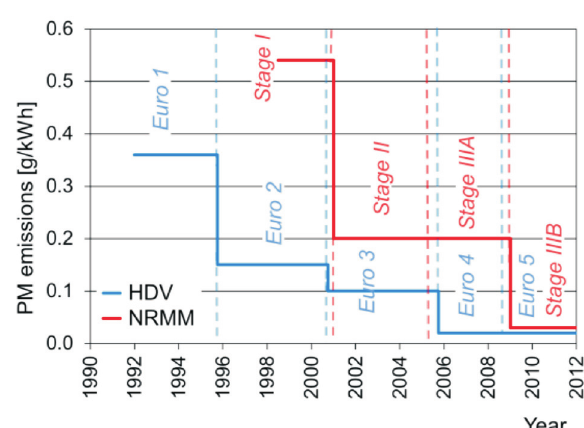
Fig. 12. Comparison of the admissible values of the PM emission for the HDV and NRMM engines (130–560 kW)